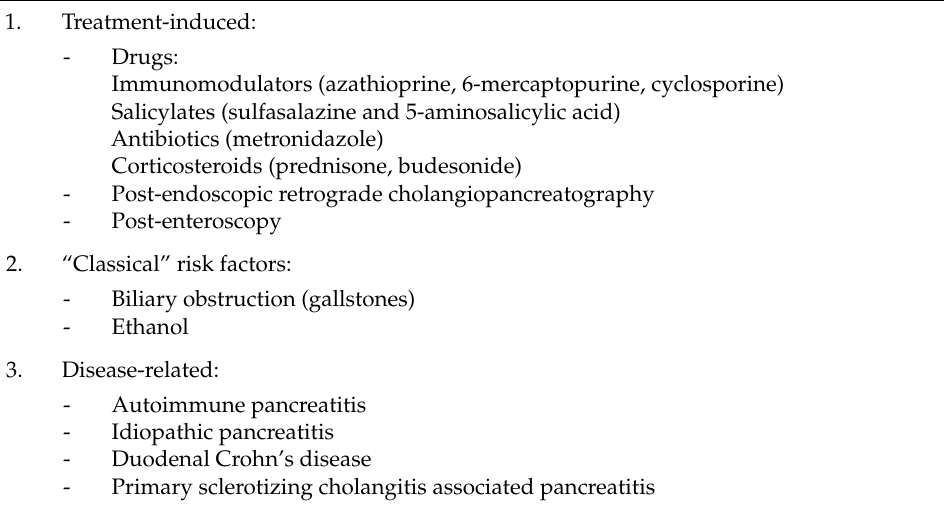
Table 2. Etiology of acute pancreatitis in IBD (based on